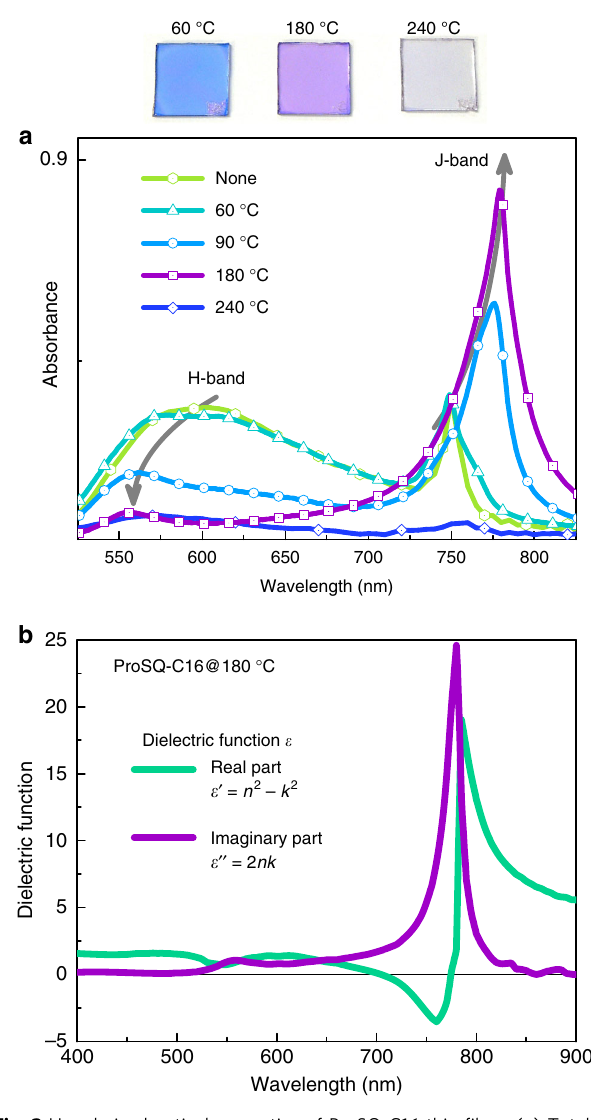
Fig. 3 Unpolarized optical properties of ProSQ-C16 thin fi lms. ( a ) Total absorbance spectra − log( T ) of spin-casted ProSQ-C16 thin fi lms on glass, with thicknesses around 25 nm, thermally annealed at the indicated temperatures. Annealing at 120 °C, 180 °C and 210 °C results in similar spectra, and for clarity of the presentation only the absorbance measured at 180 °C is shown. Gray arrows are to guide the eye to see the evolution of the H- and J-band with annealing temperature. Above the graph photographs of selected samples annealed at the indicated temperatures are shown. b Effective real and imaginary part of the dielectric function ε ′ = n 2 − k 2 and ε ′′ = 2 nk , respectively, for ProSQ-C16 thin fi lms annealed